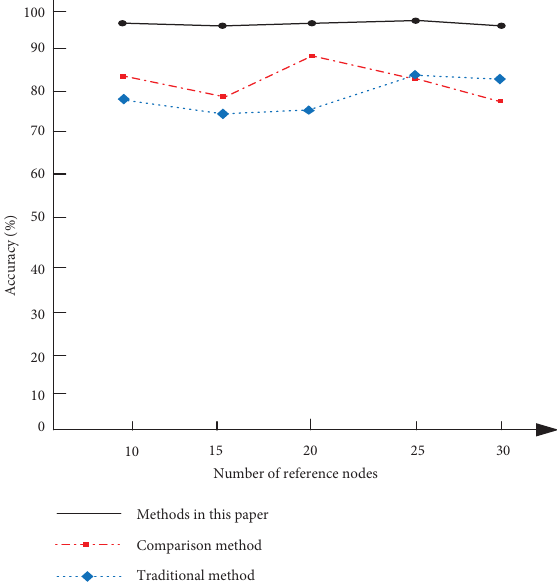
Figure 19: Positioning accuracy comparison